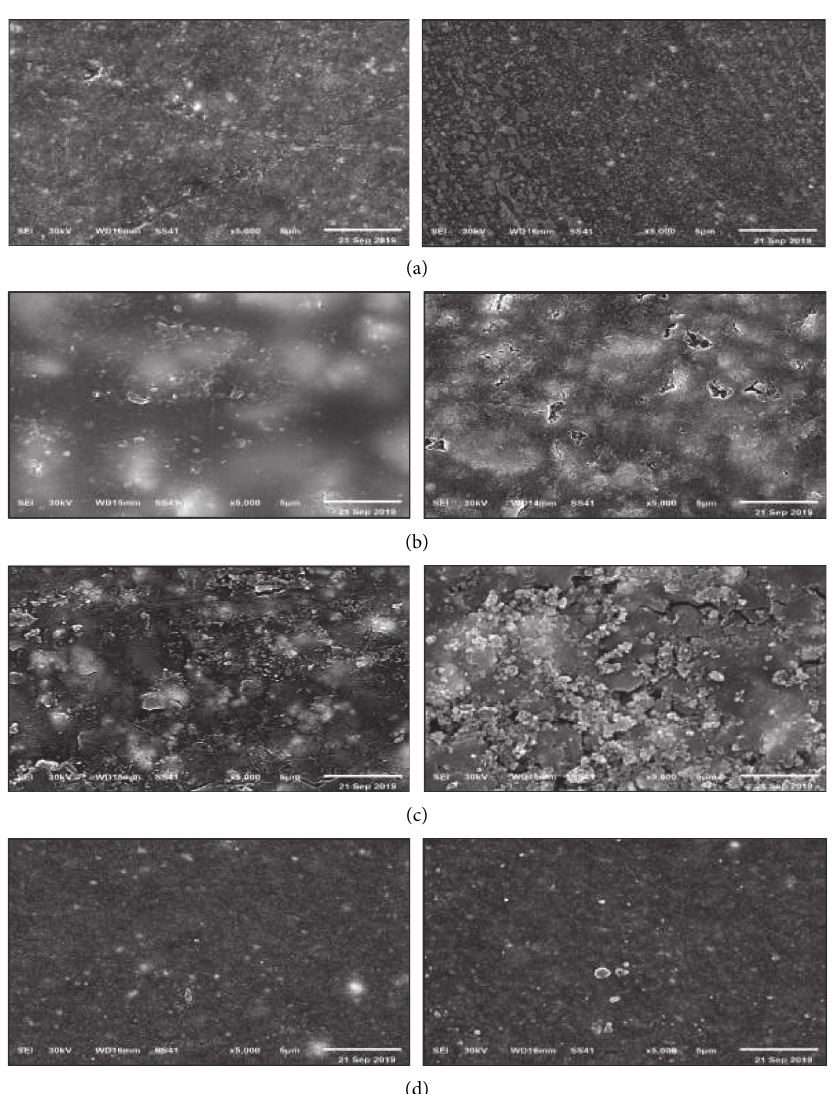
Figure 6: Representative scanning electron micrographs of the used materials: (a) nanohybrid, (b) RMGI, (c) amalgomer, and (d) bulk-fill. Images were visible at baseline (1) and after desensitizing agent application